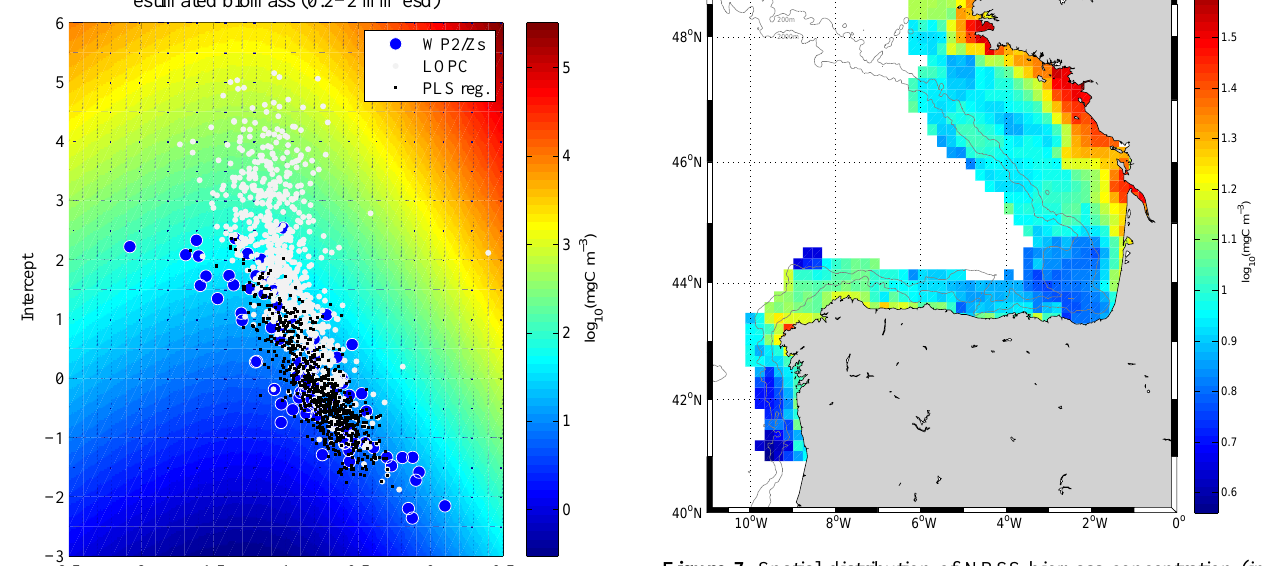
Figure 7. Spatial distribution of NBSS biomass concentration (in log 10 mgCm − 3 ) estimated by the PLS (partial least square) from the surface to a maximum of 100m